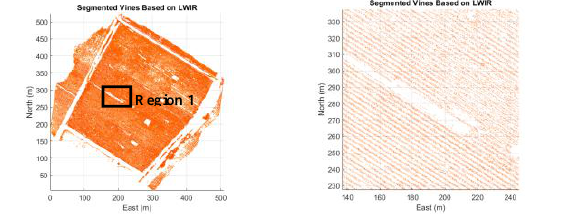
Figure 8: Result of vine identification algorithm based on LWIR data alone (left) for the entire vineyard and (right) for an expanded area (Region